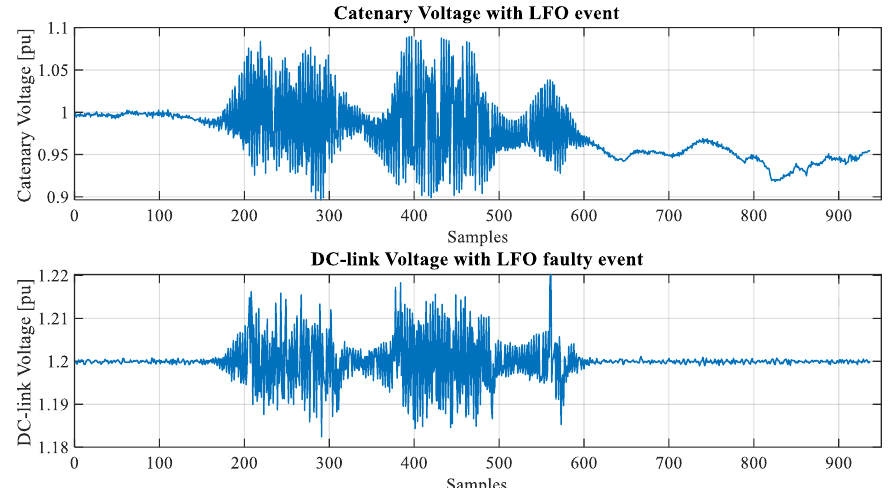
Figure 3. Catenary and DC-Link voltage (pu) under LFO faulty event.